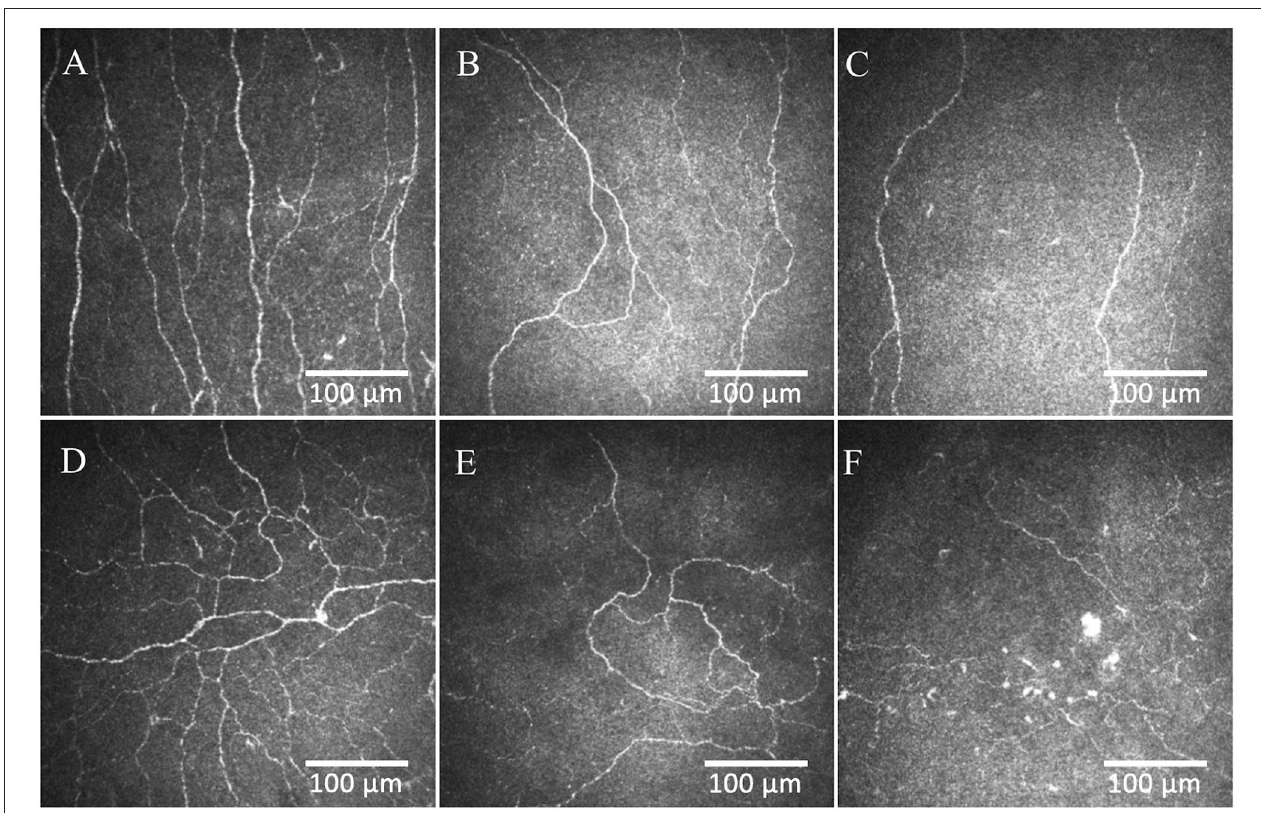
FIGURE 2 | CCM images of the central cornea and inferior whorl in a healthy control (A,D) , patient with painless (B,E) and painful (C,F) diabetic